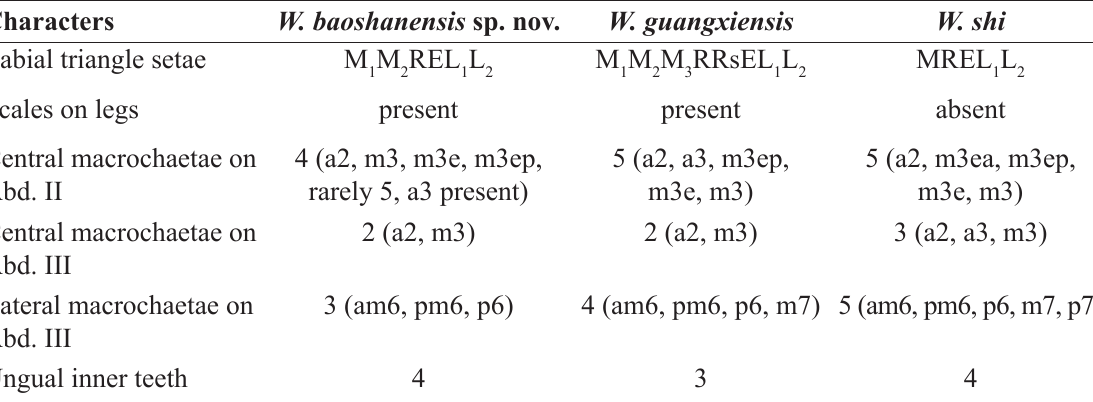
Table 1. Comparison of W. baoshanensis sp. nov., W. guangxiensis Shi & Chen, 2004 and W. shi Pan, Zhang & Chen,